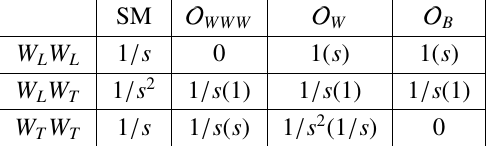
Table 1. Behavior at large s of the SM, its interferences with the dimension-six operators and, in parentheses, the squared amplitudes of the dimension-six operators for the di ff erent polarizations of the two W